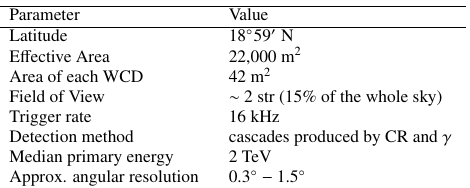
Table 1: HAWC Main Detector Parameters Parameter Value Latitude